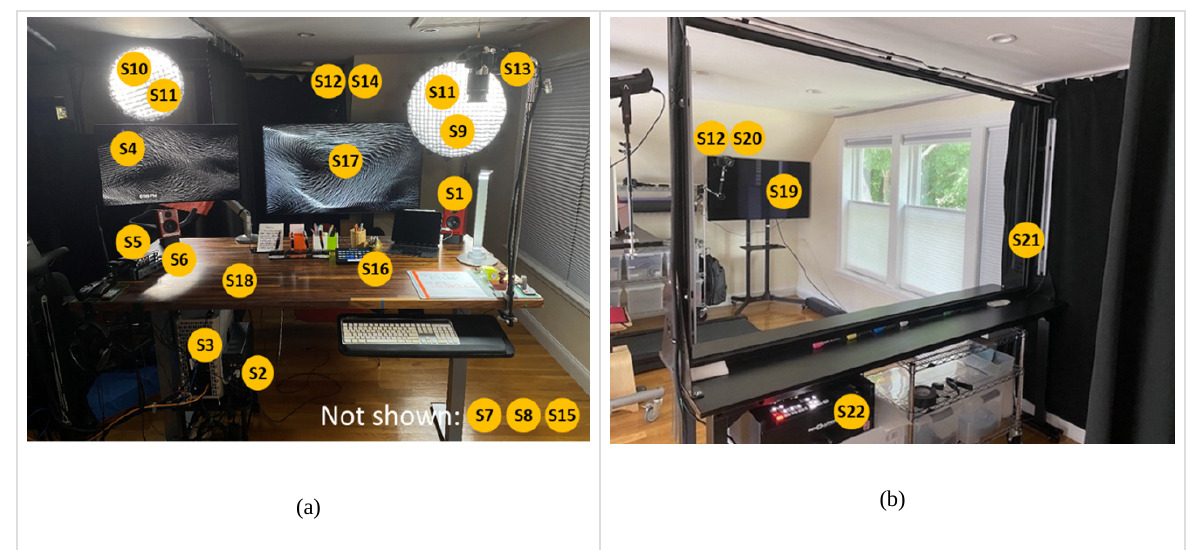
Figure E1. Sean Willems’s home studio with labeled components: (a) talking head station; (b) lightboard